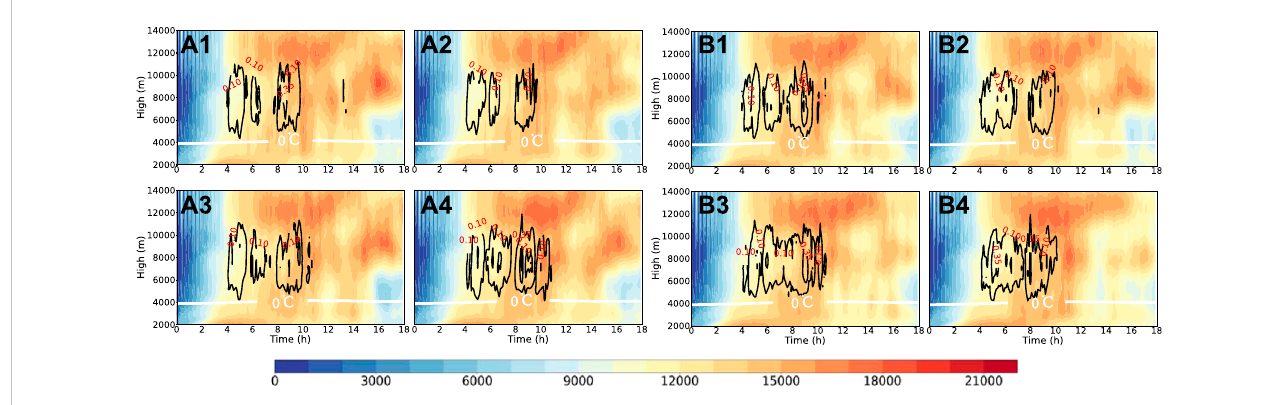
FIGURE 9 Timevariationofheightdistributionofthenumberofupdraftgrids(w > 0.1ms − 1 )withthecontouroftheproportionofupdraftgreaterthan15ms − 1 inthe total updraft, and the solid white line is the height of 0 degrees Celsius: (A) TH-AU. (B) MY-AU; (1) NCCN50 (2) NCCN200 (3) NCCN2000 (4) NCCN10000.